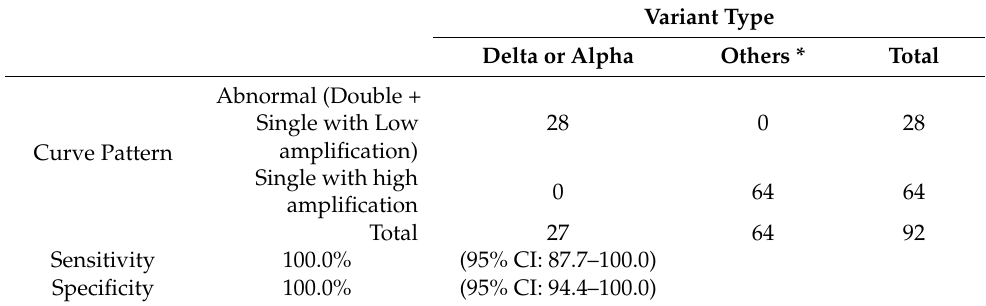
Table 2. The sensitivity and specificity of RdRp/S double or low amplification curve pattern analysis. Variant Type Delta or Alpha Others * Total Abnormal (Double + Single with Curve Pattern